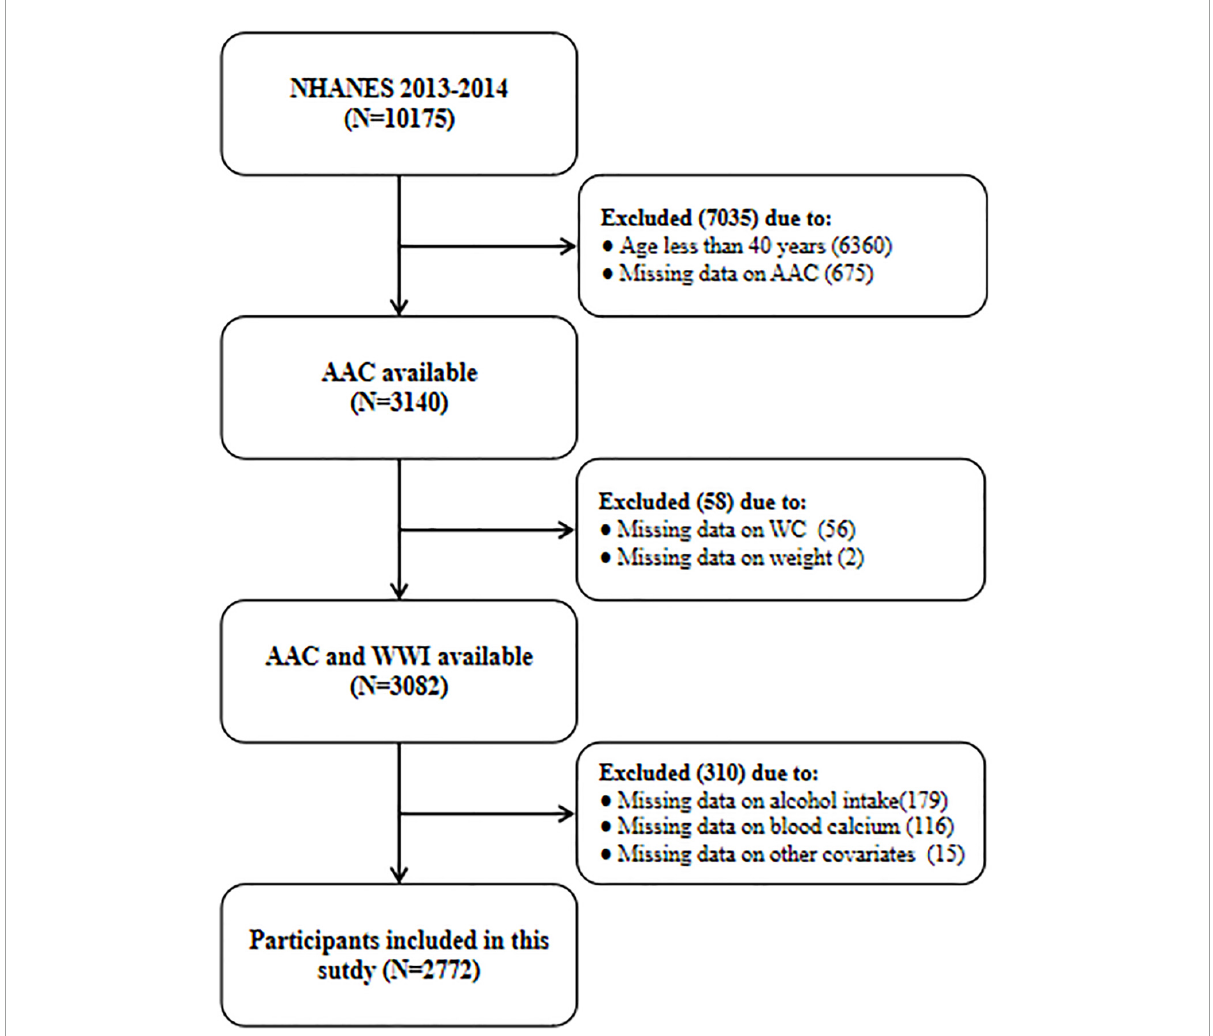
FIGURE1 The flow chart of participant selection. NHANES, National Health and Nutrition Examination Survey; AAC, abdominal aortic calcification; WWI, weight-adjusted-waist index; WC, waist